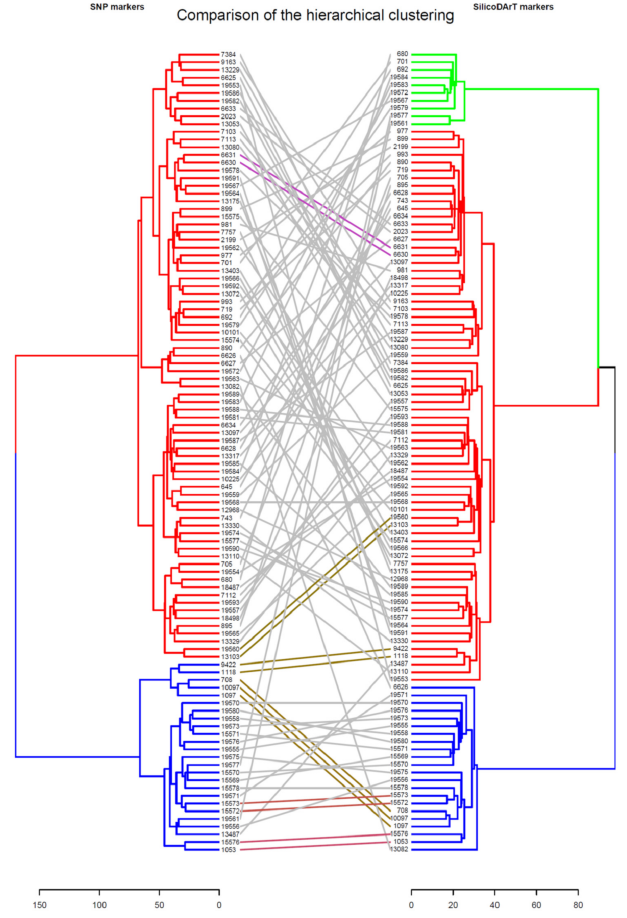
Figure 4. Hierarchical clustering of Rhodes grass accessions using SNP and SilicoDArT markers. Table 2. Analysis of molecular variance (AMOVA) of clusters identified using high throughput DArTSeq markers. Marker